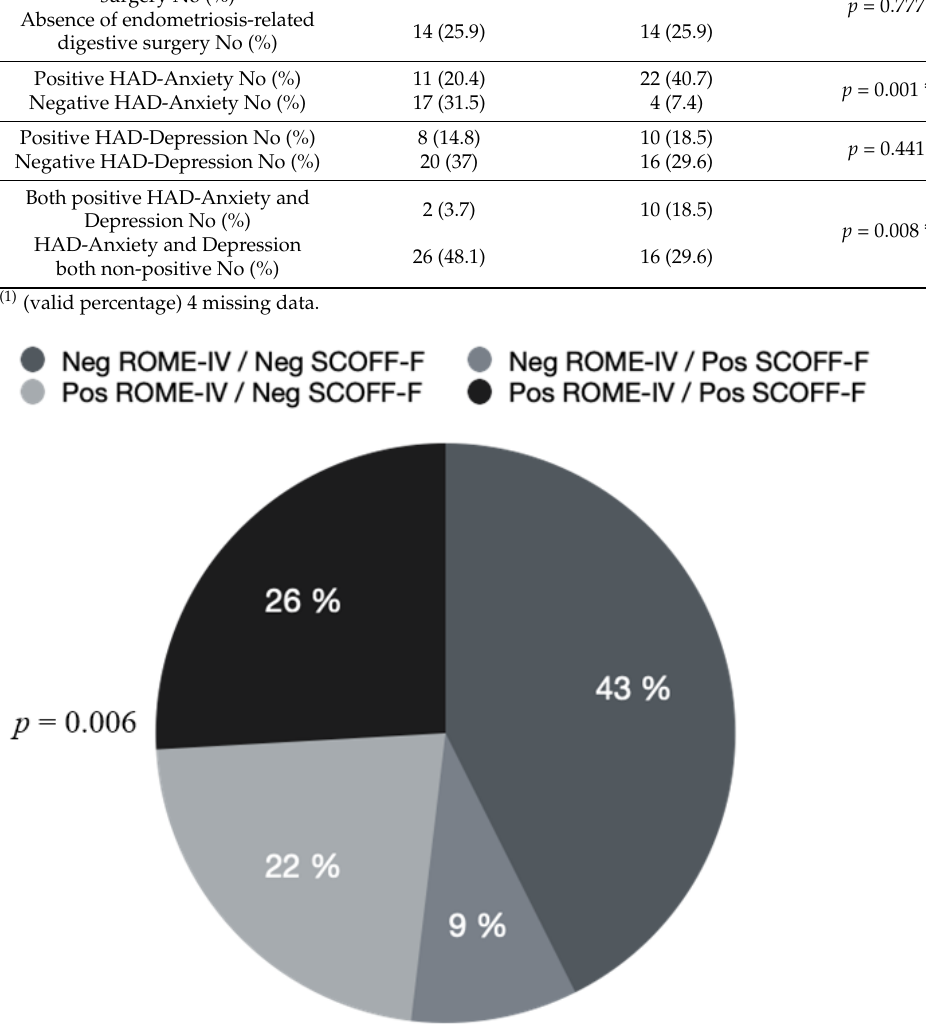
Table 3. ROME-IV score and other variables of interest in the 54 responding patients. EAT-26: Eating Attitudes Test-26; HAD: Hospital Anxiety and Depression Scale; *, p < 0.05.